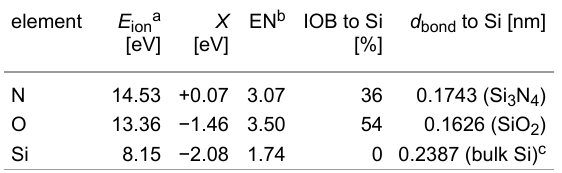
Table 1: Fundamental properties of N, O and Si: Ionization energy ( E ion ), electron affinity ( X ), electronegativity (EN), ensuing ionicity of bond (IOB) to Si and experimental values of characteristic bond lengths [29]. See also to Supporting Information File 1 for the latter. element